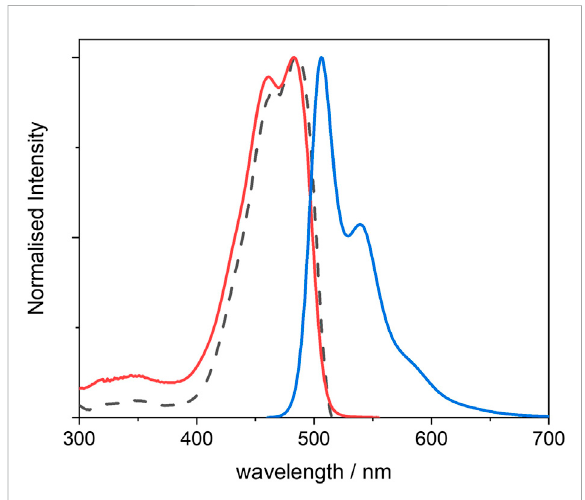
FIGURE 2 Normalised UV-visible absorption (red), excitation (dotted black) and emission (blue) spectra of 4, recorded from 10 − 6 M THF solutions; excitation wasmeasuredat λ em =540 nm,andemission was measured using λ exc = 440